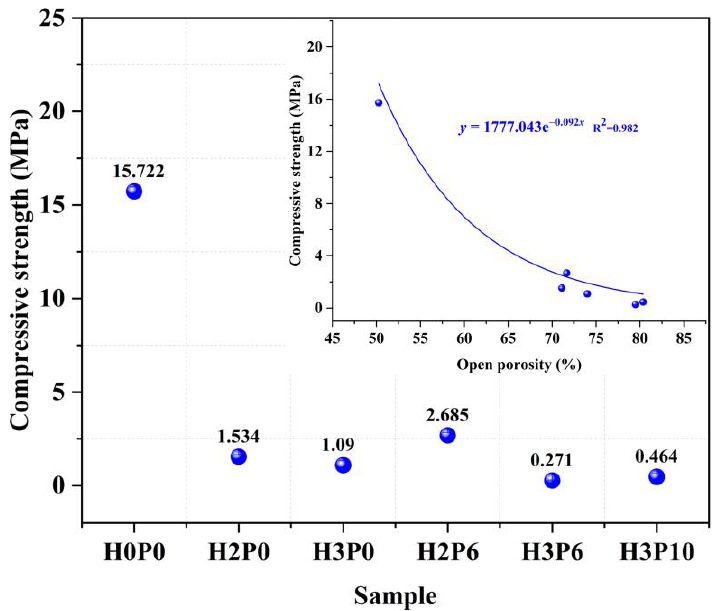
Figure 20. Compressive strength of matrix and geopolymer foams.